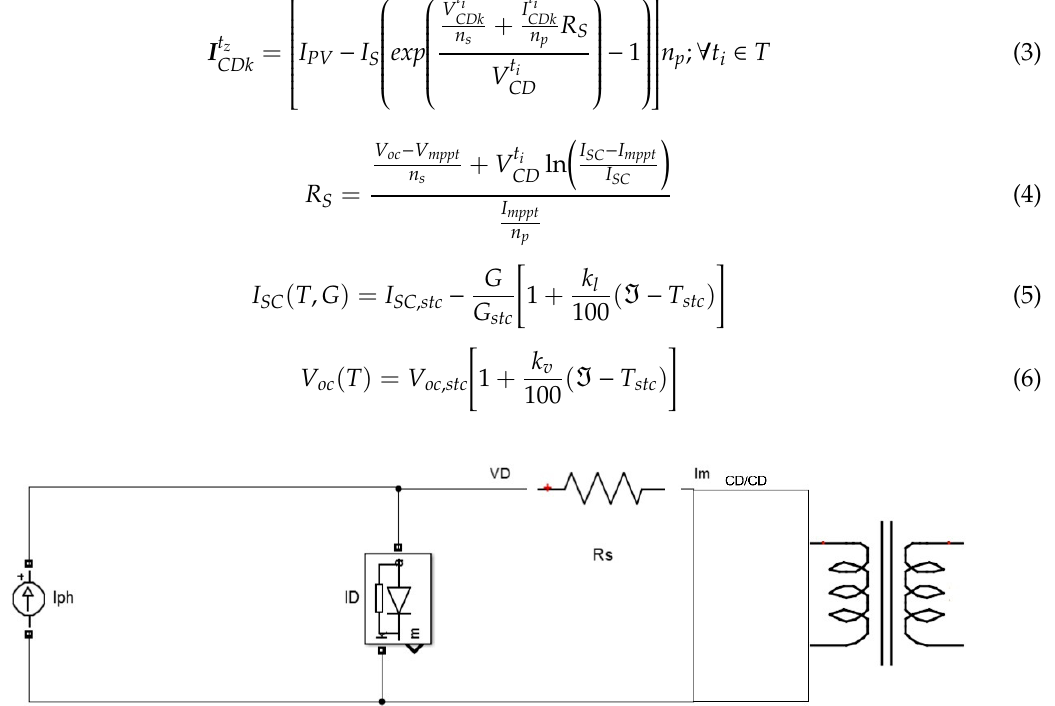
Figure 2. Schematic model of a photovoltaic module.